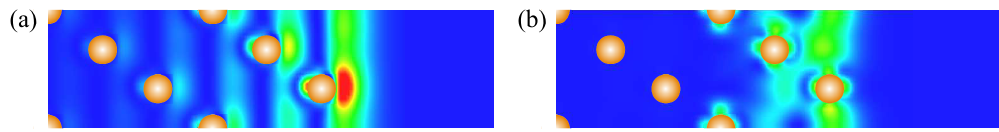
Figure 5. Charge density distribution of (a) Γ 1 , (b) M 2 surface states on clean Au(111) surface obtained from the WSOC calculation. The Au atomic positions are shown by yellow